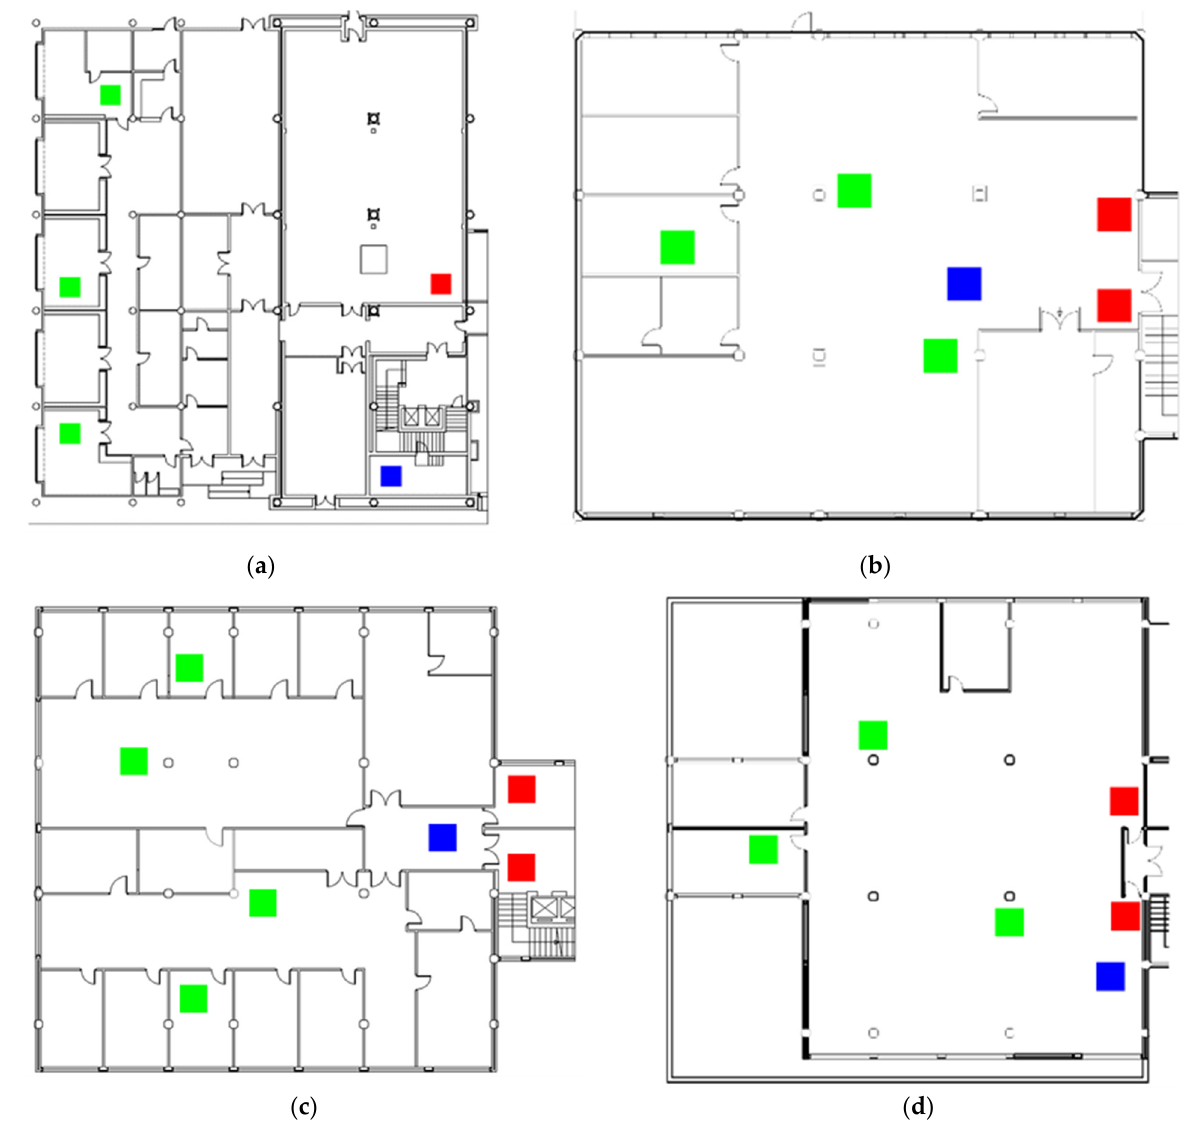
Figure 3. Sensor distribution on each floor. Temperature, humidity, and CO 2 sensors are marked as green squares, while blue and red squares indicate the electric consumption and thermal demand sensors, respectively. ( a ) Ground Floor, ( b ) First Floor, ( c ) Second Floor, ( d ) Third Floor.